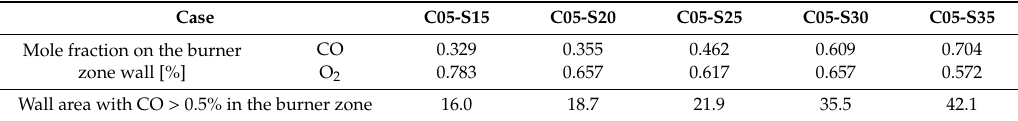
Table 5. Average mole fractions of CO and O 2 and the area with CO > 0.5% on the wall of the burner zone.